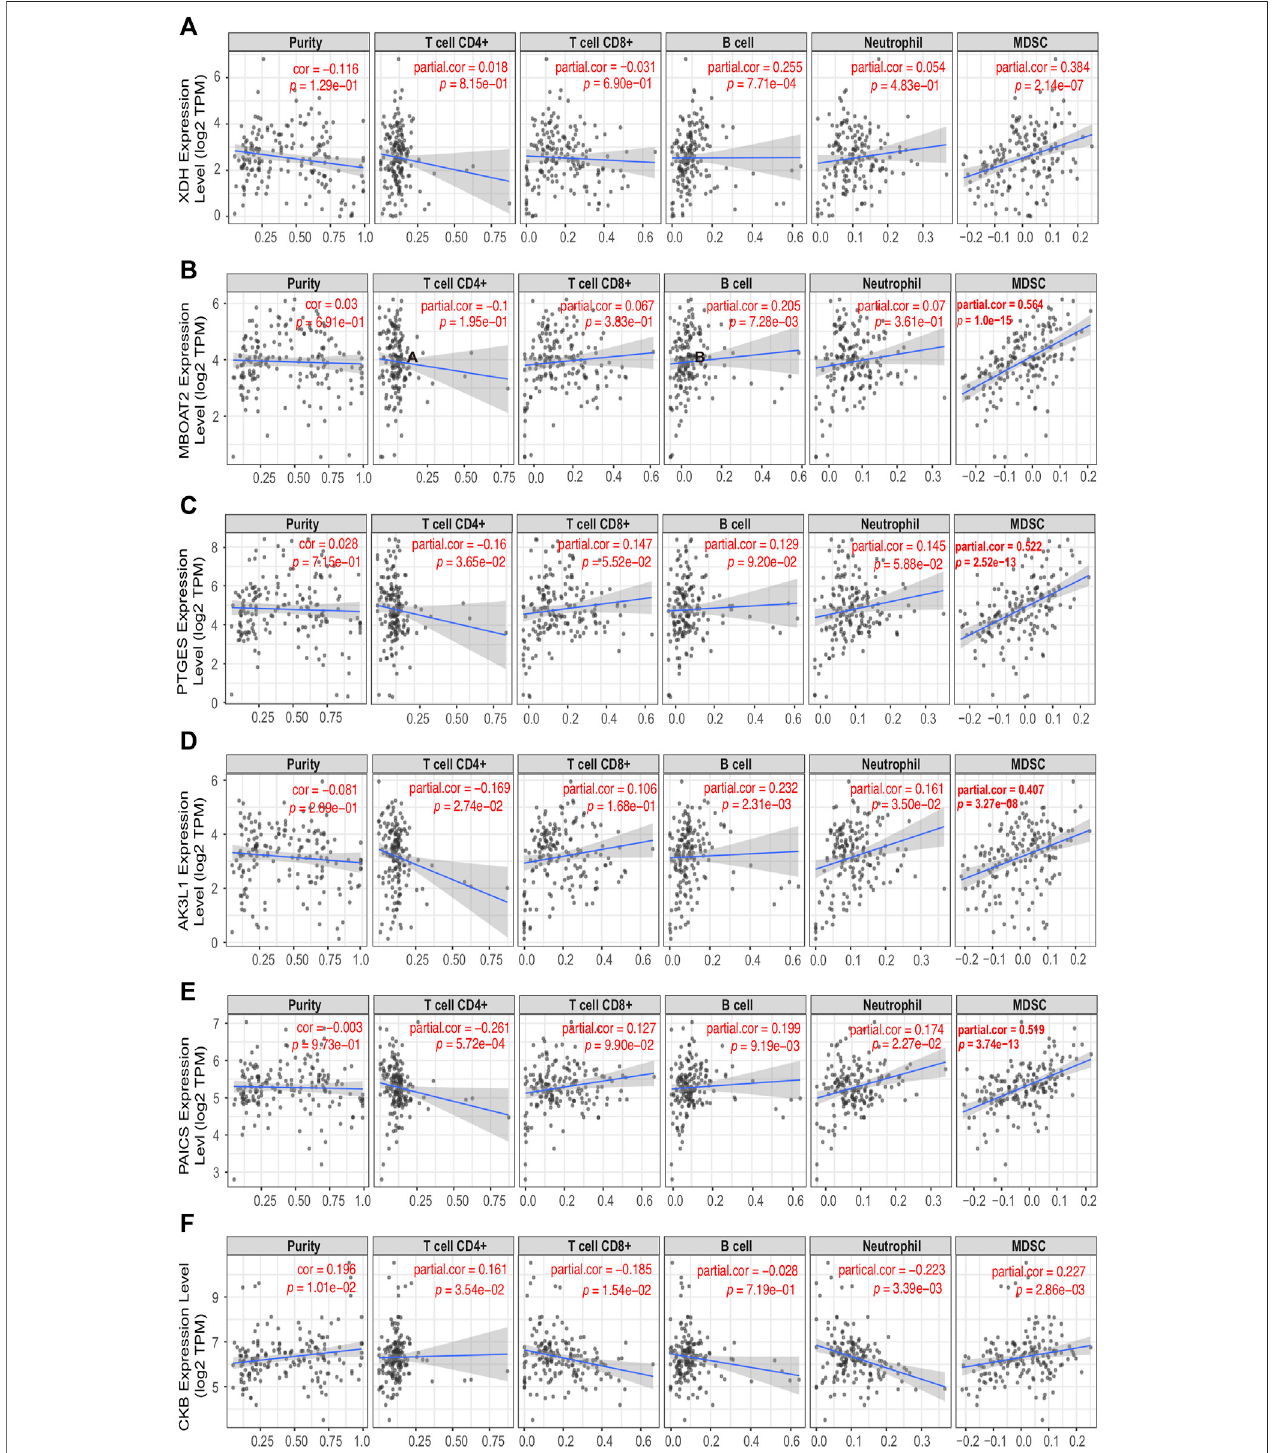
FIGURE 6 | Correlation among the expressions of six PDEMRGs and different immune cell types in PAAD patients obtained using TIMER 2.0 database (A – F) Correlation among the expression levels of XDH , MBOAT2 , PTGES , AK3L1 , PAICS , and CKB and in fi ltration of immune cells in PAAD.